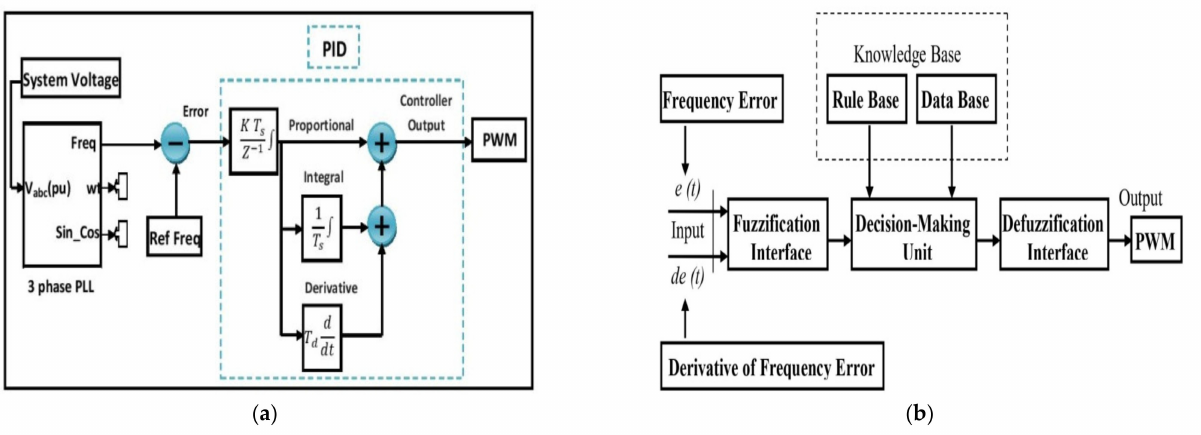
Figure 7. ( a ) Frequency control scheme using PID controller. ( b ) Frequency control scheme using fuzzy logic